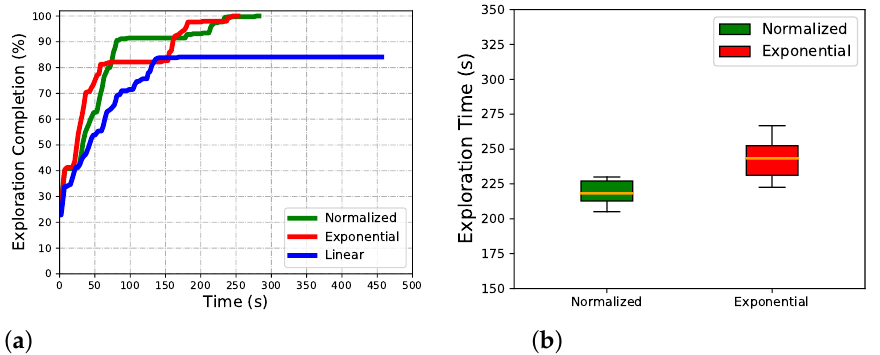
Figure 7. Algorithm comparsion in indoor scenario. ( a ) Exploring completion degree curve. ( b ) Total completion time.